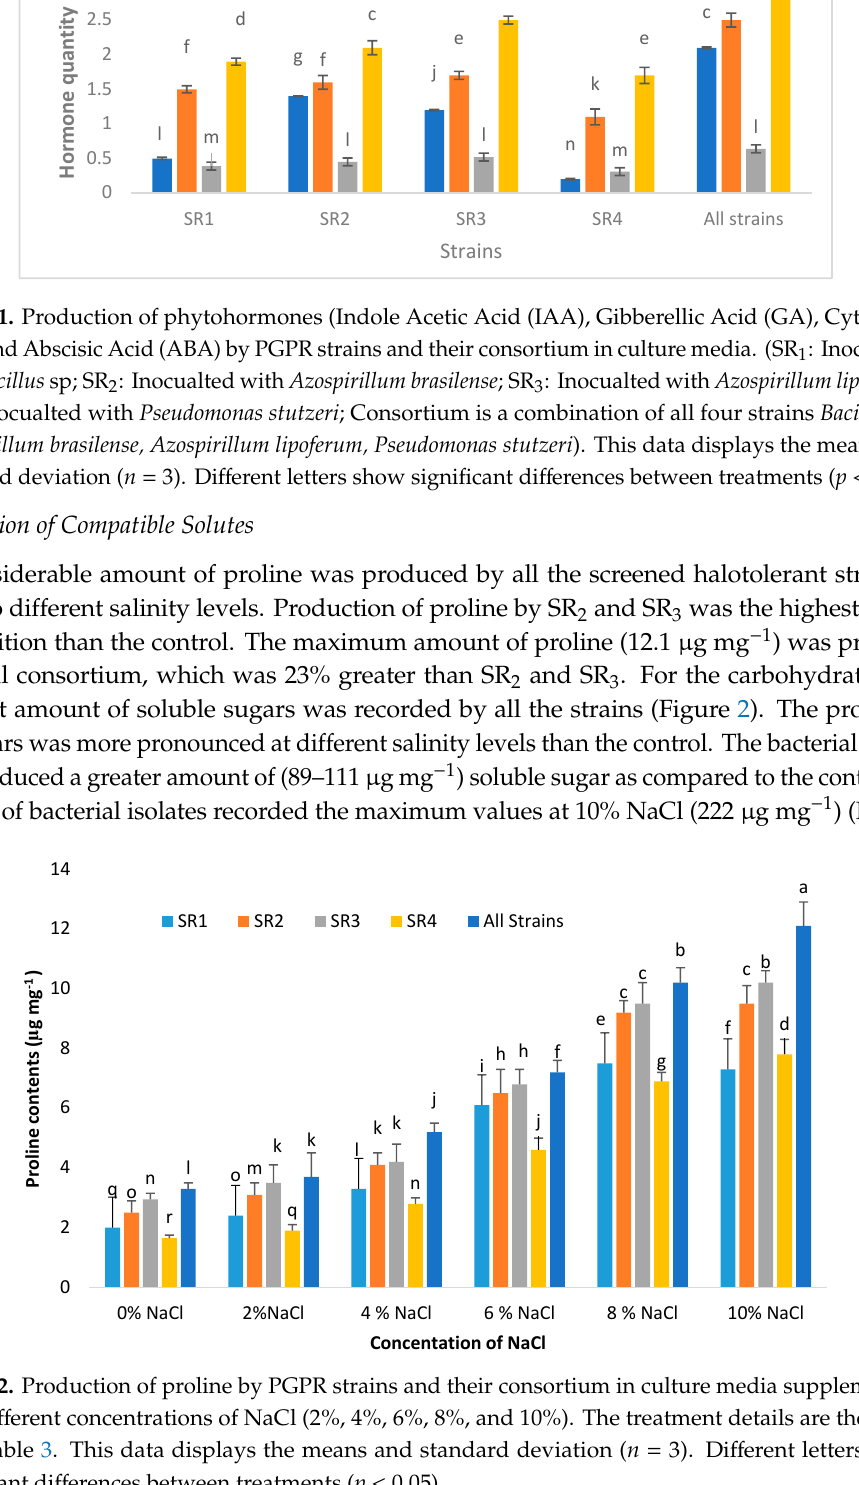
Figure 3. Production of total soluble sugar by PGPR strains and their consortium in culture media supplemented with different concentrations of NaCl (2%, 4%, 6%, 8%, and 10%). The treatment details are the same as in Table 3. 3.7. Effect of PGPR Inoculation on the Biomass of Wheat (Triticum Aestivum L.) Plants Grown under Salinity Stress The overall decrease of 30% in the plant biomass of wheat plants was observed due to salt stress. However, the bacterial isolates exerted a significant positive influence on wheat growth and resulted